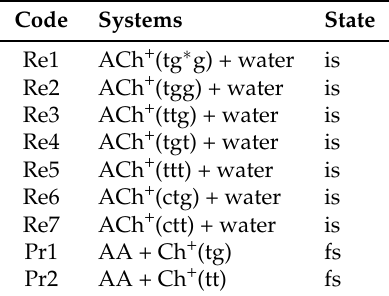
Table 7. The code for reactants (initial state (is)) and products (final state (fs)) from Scheme 1.